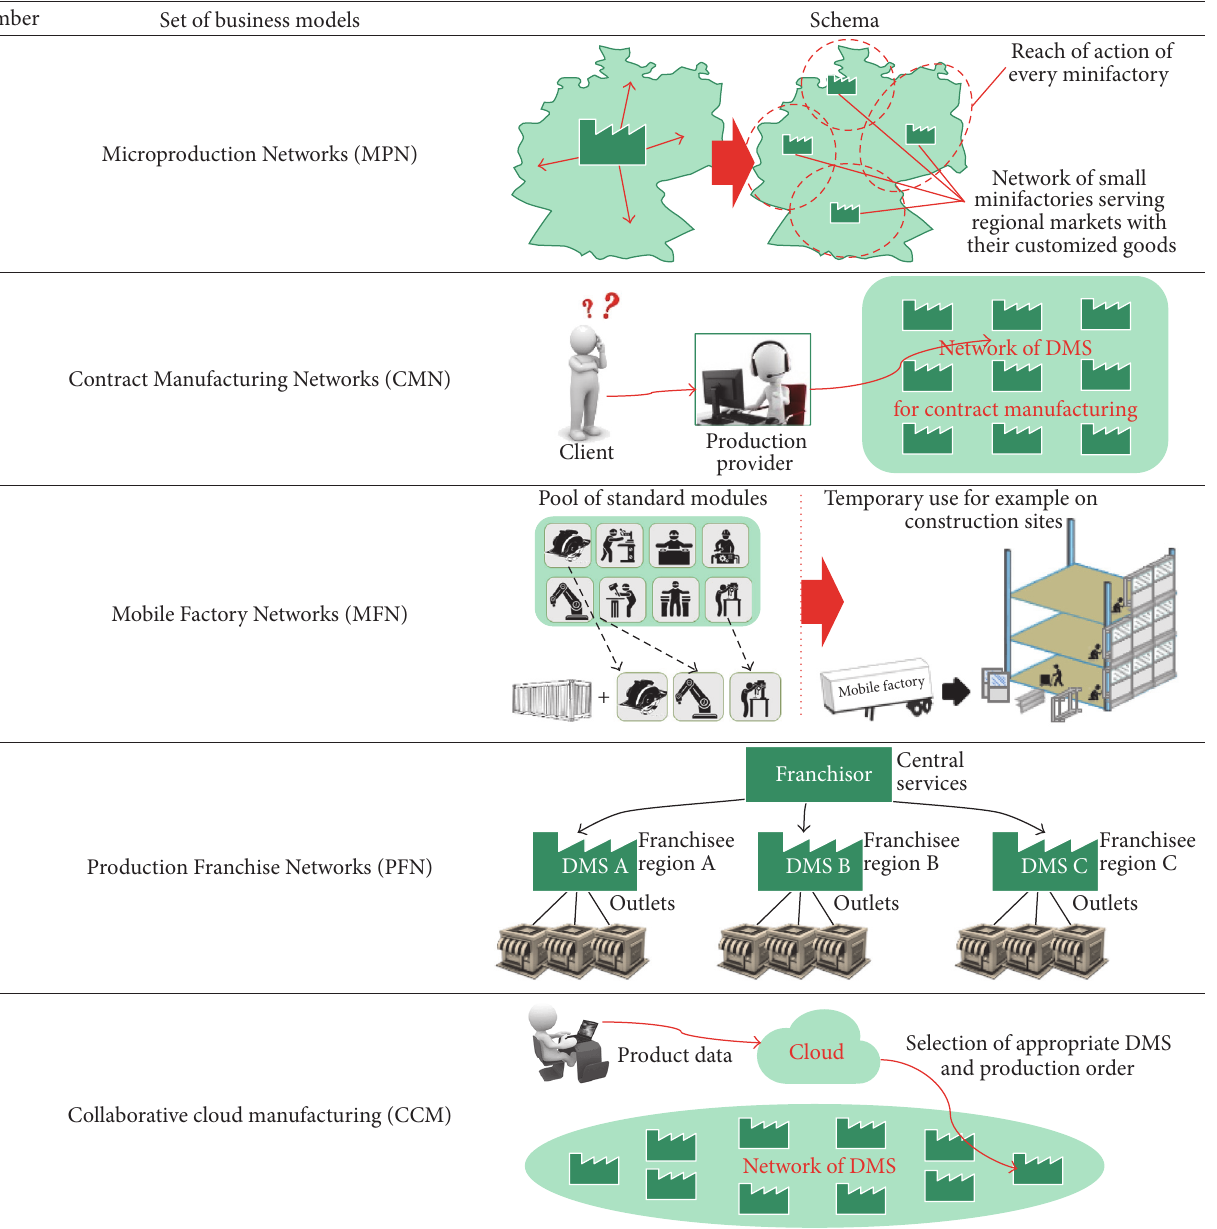
Table 1: Set of business models for distributed manufacturing